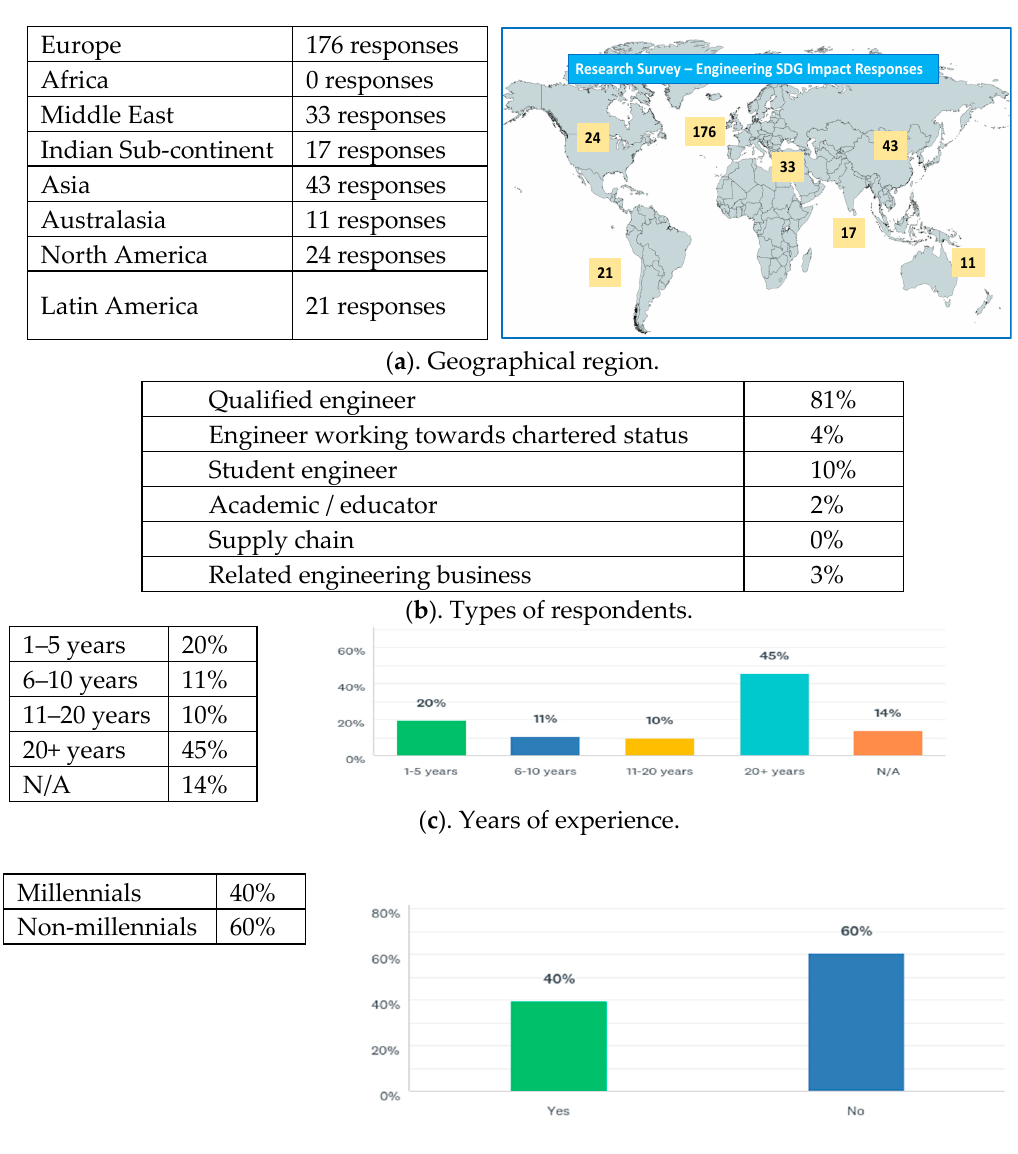
Figure 6. Statistical descriptive data from survey.